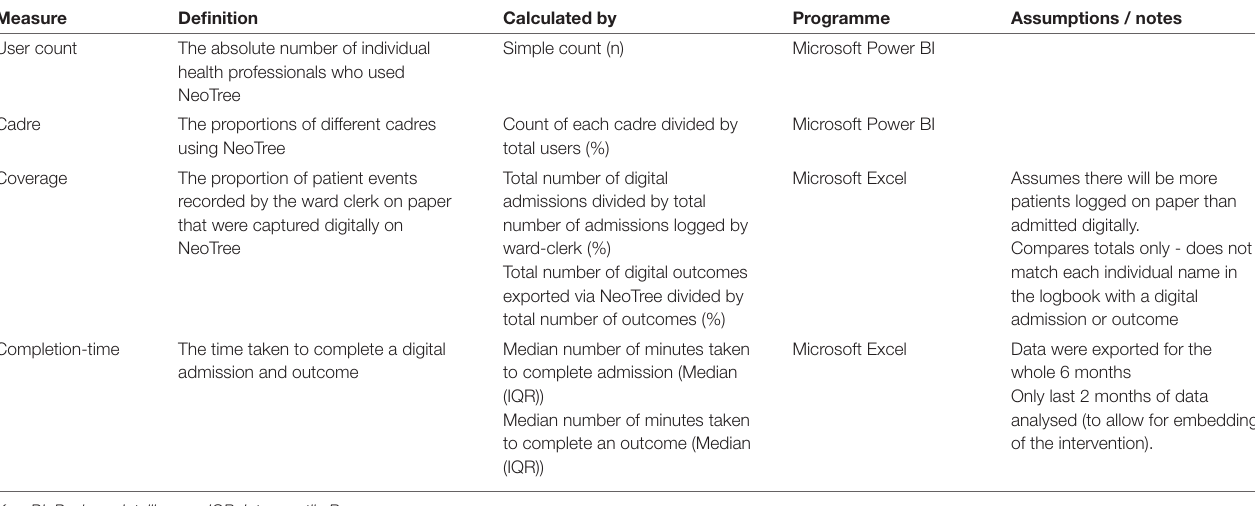
TABLE 2 | Usage metrics.